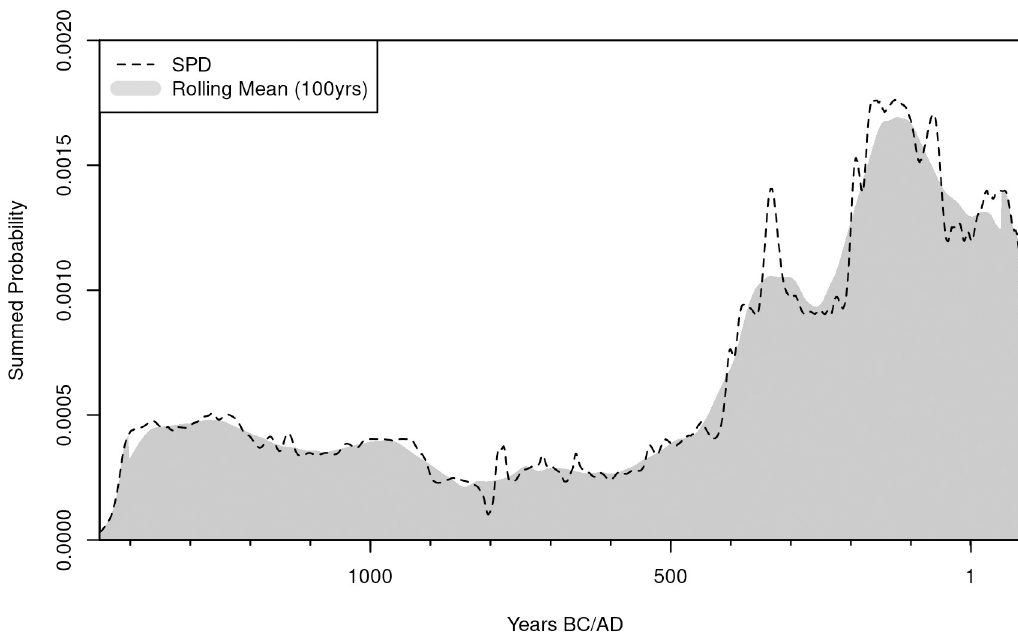
Fig 1. Observed Summed Probability Distribution (SPD) of radiocarbon dates for the island of